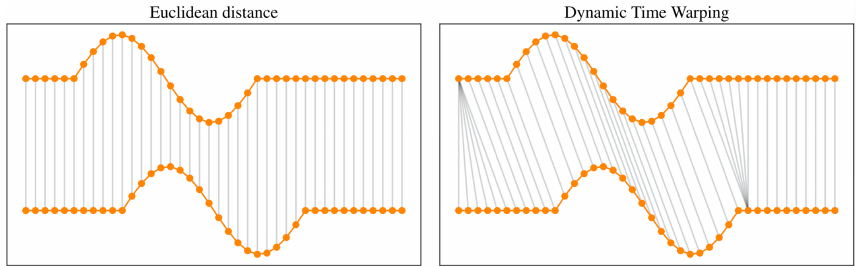
Figure 3. A comparison between dynamic time warping (DTW) and Euclidean distance, reproduced with permission from [14], copyright from Professor Romain Tavenard 2023. Note that the two time series have a similar overall shape but are not aligned on the time axis. Euclidean distance, which assumes the i th point in one sequence is aligned with the i th point in the other, may produce a pessimistic dissimilarity measure. The non-linear dynamic time warped alignment allows a more intuitive distance measure to be